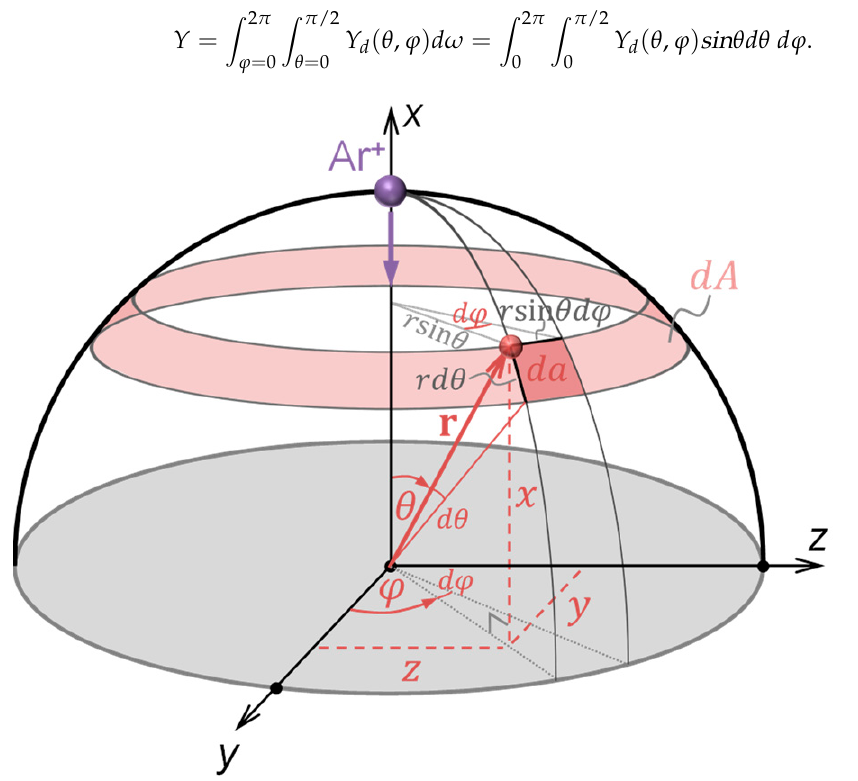
Figure 2. Schematic of the geometry in the evaluation of the SRIM data. Ions impact the target surface and cause the emission of sputtered atoms in different spatial directions.